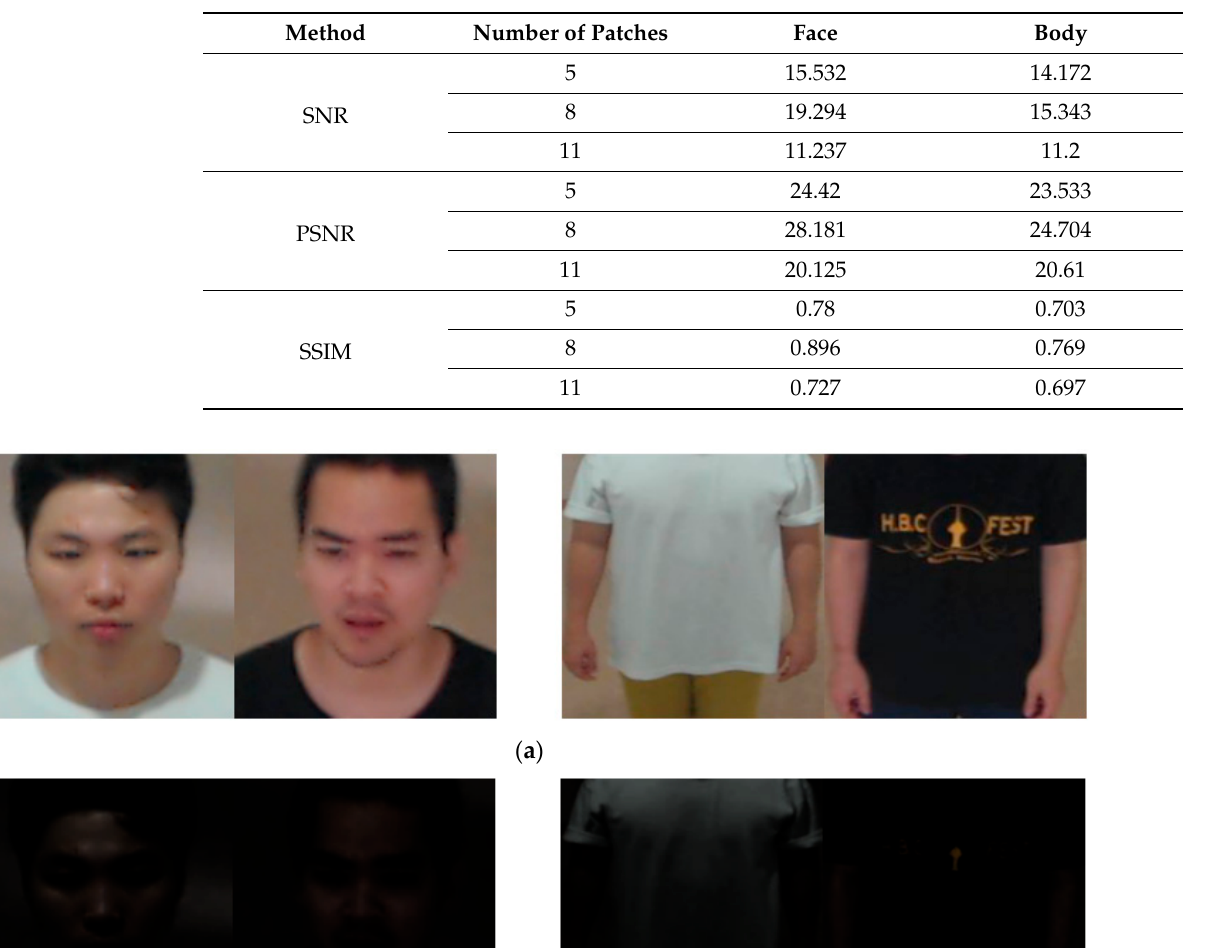
Table 6. Performance comparisons with enhanced images by modified EnlightenGAN according to the number of patches in the discriminator.